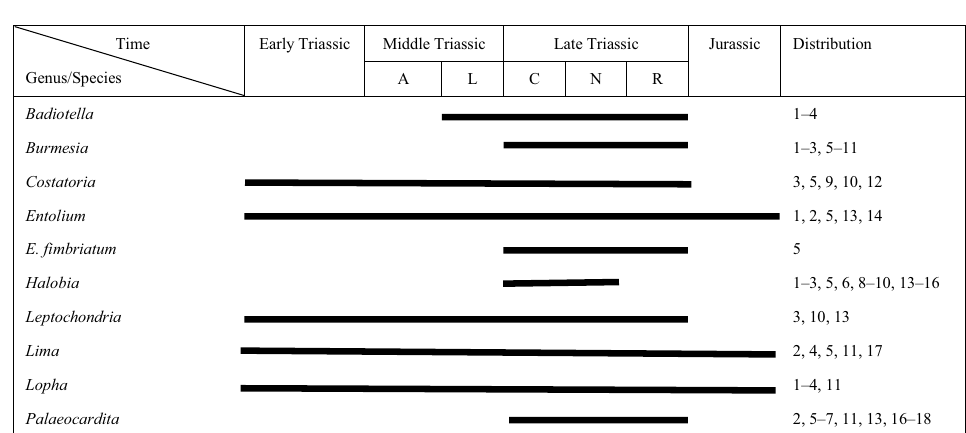
Table 2. Stratigraphic distribution of bivalves in the Sêwa Formation of the Rigenco section in the northeastern Riganpeicuo area, Tibet. A = Anisian; L = Ladinian; C = Carnian; N = Norian; R = Rhaetian; 1 = Sichuan Province, China; 2 = Tibet, China; 3 = Guizhou Province, China; 4 = Tethys; 5 = Yunnan Province, China; 6 = Qinghai Province, China; 7 = Myanmar; 8 = Indonesia; 9 = Japan; 10 = Vietnam; 11 = Indochina; 12 = Guangxi Province, China; 13 = North American; 14 = Europe; 15 = Canada; 16 = Thailand; 16 = Iran; 17 = New Zealand; 18 = South American.